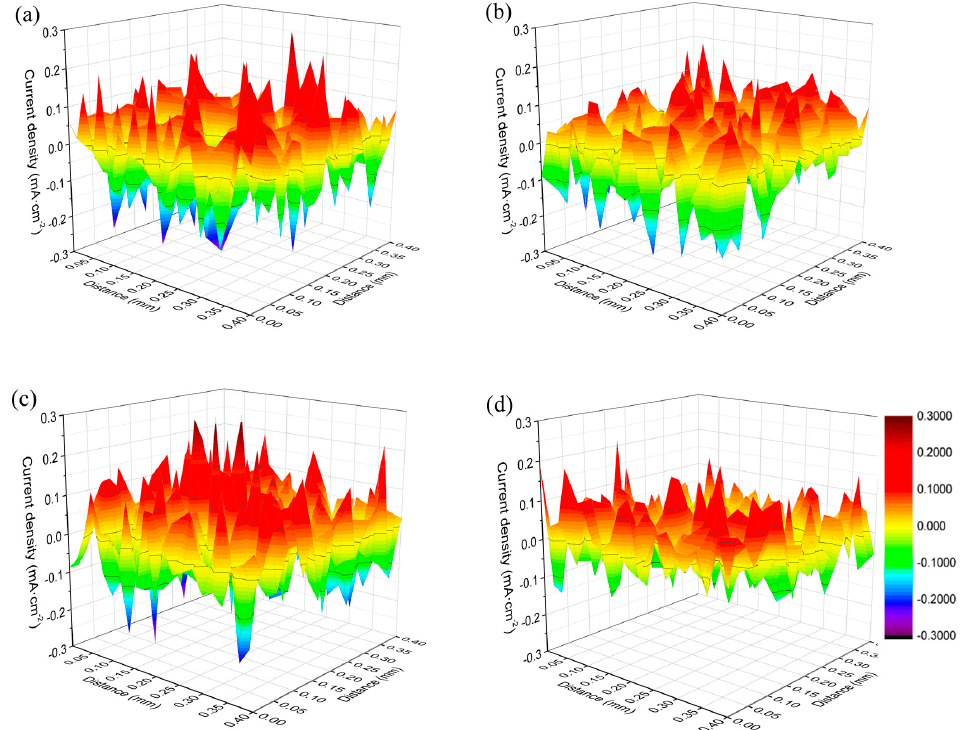
Figure 11. SVET images of the local current distributions on the metal surface of ( a , b ) Al deoxidized steels and ( c , d ) Ti/Zr deoxidized steels after immersion in 0.5 wt.% NaCl solution for different times. ( a , c ) Immersed for 10 min, ( b , d ) immersed for 1 h.